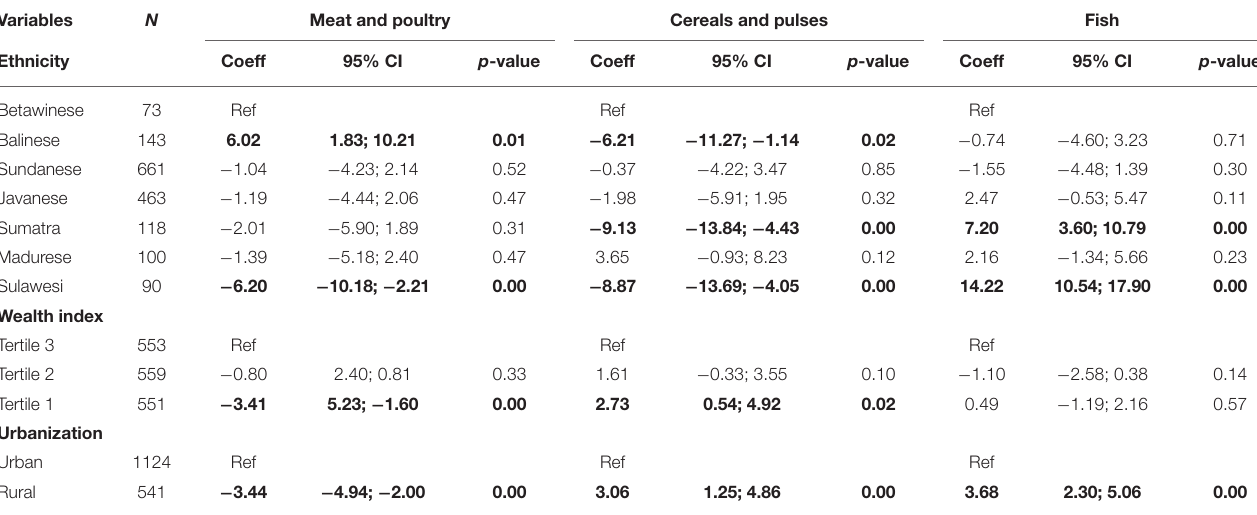
Model adjusted by age, gender, marital status, number of children, and all variables in the Table. Significant values are indicated in bold.